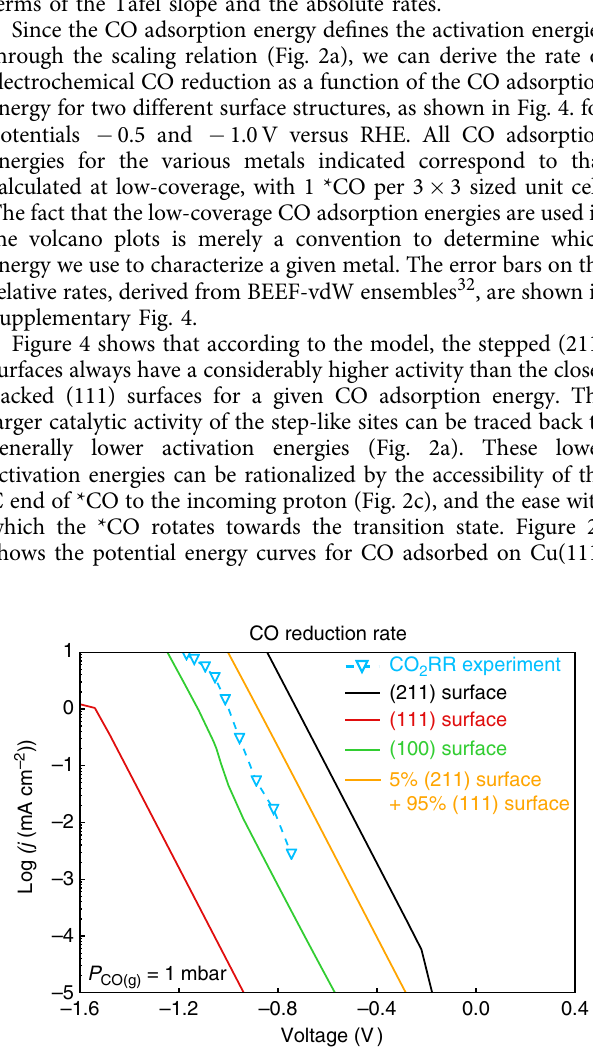
Figure 3 | Polarization curves. For Cu(111), (100) and (211) facets at pH ¼ 7, 1mbar CO (g) for CO reduction to CH 4 . Experimental data is from refs 2,43 for CO 2 reduction for all post-CO products, pH ¼ 7, where a backpressure of CO of 1mbar was estimated 7 . CO 2 RR, carbon dioxide reduction